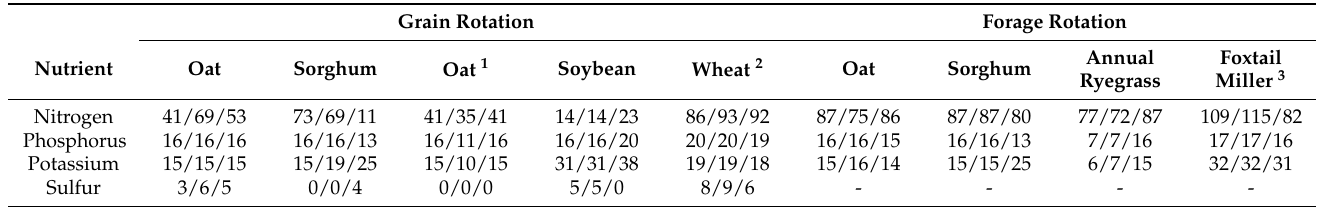
Table 3. Mineral nitrogen, phosphorus, potassium and sulfur fertilizer inputs (kg/ha) per crop per year for grain and forage annual crops in the ‘Palo a Pique’ pasture–crop rotations long-term experiment in Treinta y Tres, Uruguay (2019/2020, 2020/2021 and 2021/2022). Grain Rotation Forage